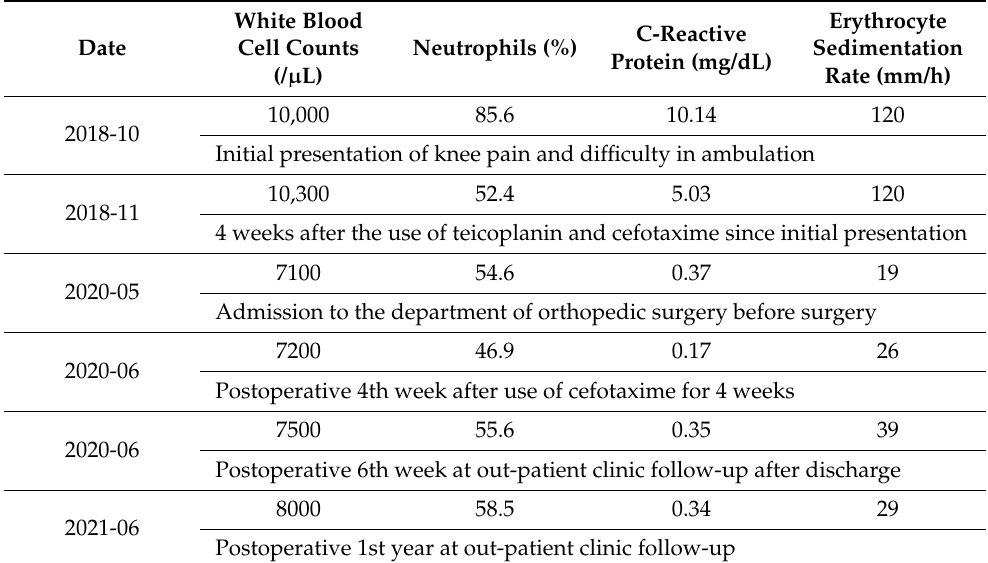
Table 1. Summary of clinical evolution and laboratory findings in a chronological order.